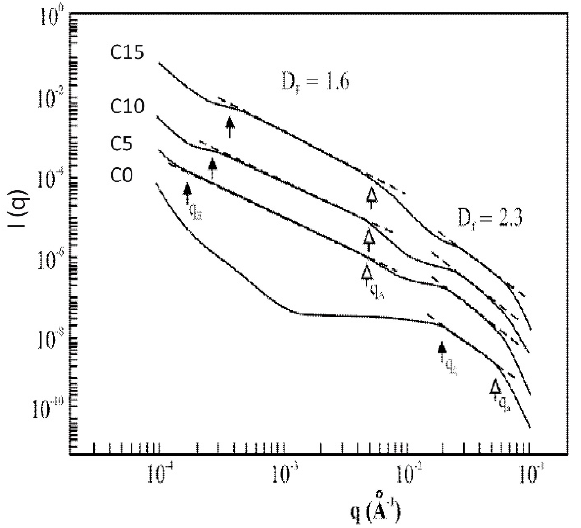
Figure 7. I(q) as measured by USAXS for the composite set (C0–C15) (from [48]). The position of the two crossovers (at q ξ and q a ) for the sample C0 are related respectively to the inverse of the cluster size ( ξ ) and the inverse of the particle size